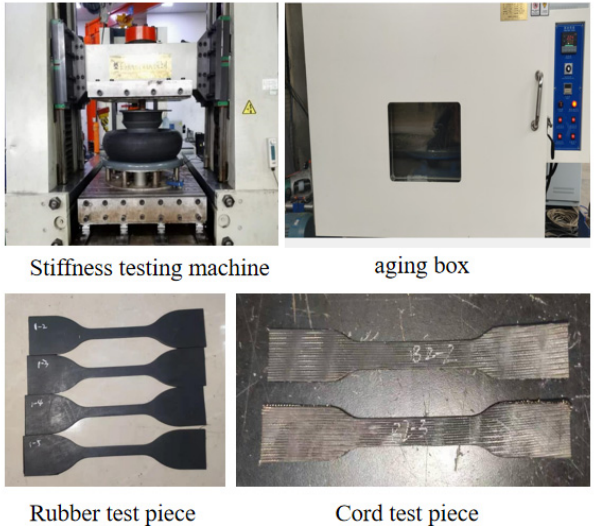
Figure 2. Test equipment and test pieces.